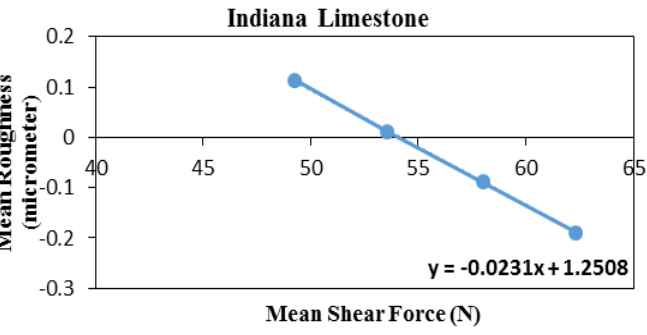
Figure 19. The mean groove roughness versus the tangential force in Indiana limestone.